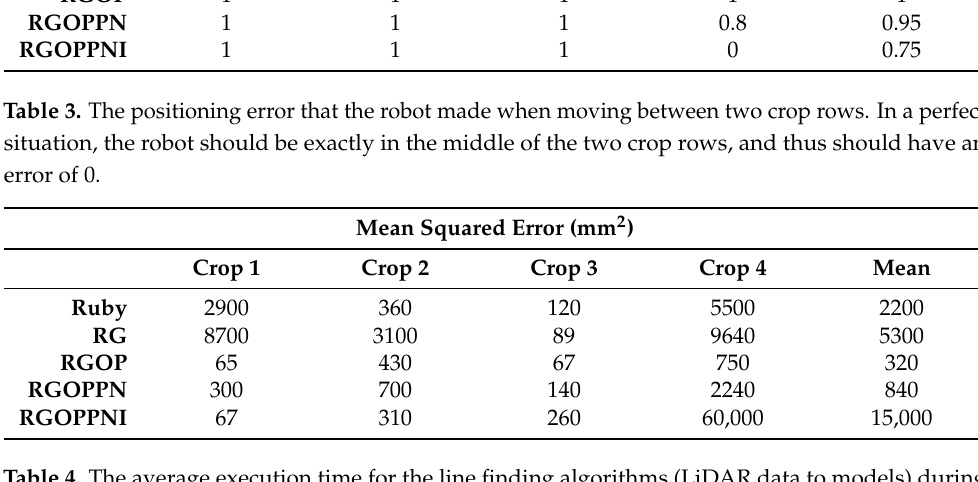
Table 4. The average execution time for the line finding algorithms (LiDAR data to models) during the 500 first iterations of each run.